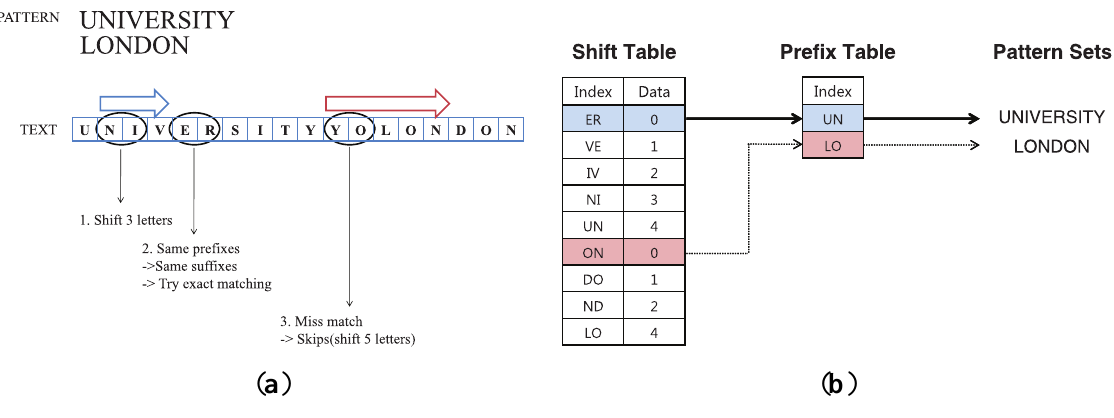
Figure 1. Shifting examples using the WM algorithm. ( a ) The shifting processes; ( b ) The two tables of